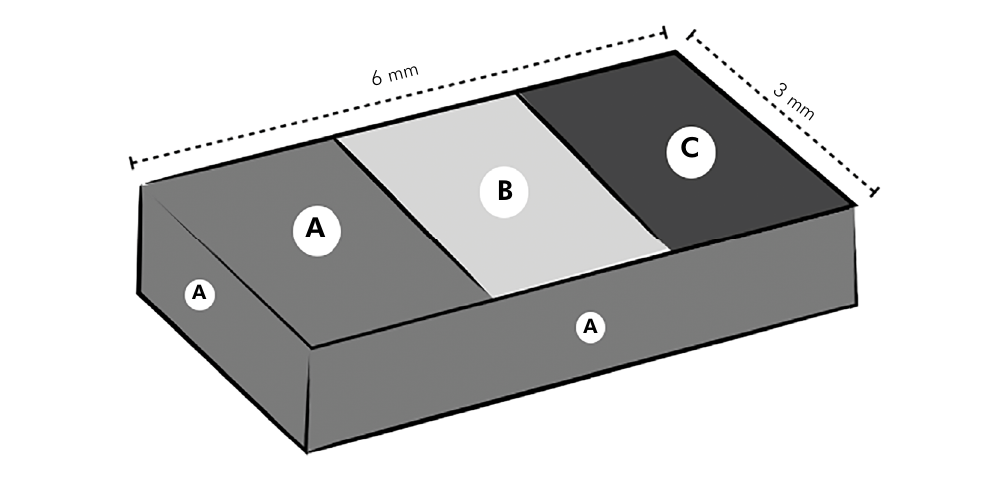
Figure 1. Surface of the enamel specimen divided into three areas v(2-mm width and 3-mm length). (A), Area coated with acid- resistant varnish. (B), Central area uncovered and considered the adjacent-to-treatment area. (C), Area that received treatments (CL, DU, or